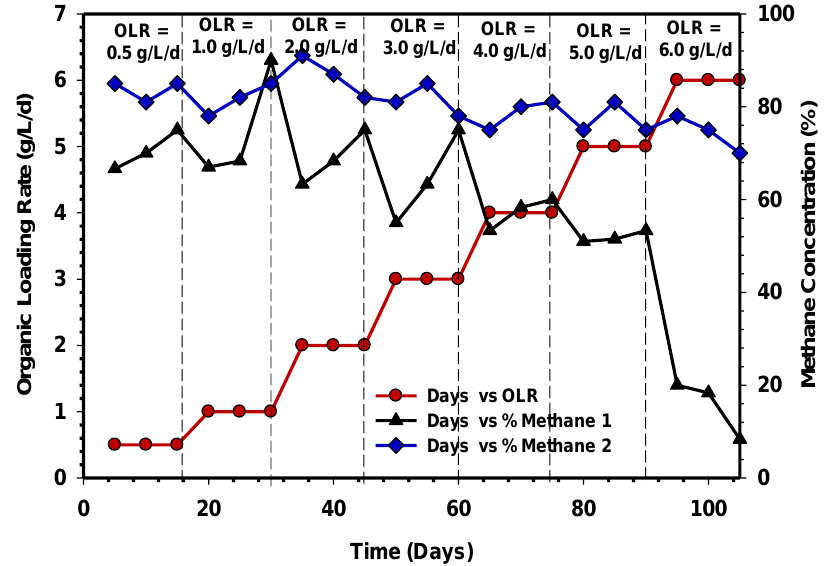
Figure 7. Methane concentration over time in UASB 1 and 2. Furthermore, the reduction in methane concentration in UASB 1 indicates a sign of inhibition of the methanogens due to VFA accumulation, as well as a low pH. However, the UASB 2 system maintained a high concentration of methane above 70% throughout the different stages of OLR (Figure 7), and this depicts a stable state of the system with no sign of inhibition. Therefore, comparatively, the performance of UASB 1 containing non- acclimatised seed sludge revealed unstable methane gas production. The two experi- mental results revealed that UASB 2 is more efficient in biogas, methane, and SMP, com- pared with a UASB 1 reactor of the same configuration and different seed sludge. A sim- ilar result was reported by Torkian et al. [15] with a UASB reactor. Still, the results ob- tained from the previous study were lower (0.2 to 0.28 LCH 4 /gCOD removed ) than UASB 2 in this study. 3.4. TAN Concentrations of the Reactors The TAN concentration profile of UASB 1 and UASB 2 over a period of time at vari- ous OLRs are presented in Figure 8. Research has shown that during protein hydrolysis in AD, a high concentration of TAN is usually produced [38]. It can be inferred that the concentration of TANs for UASB 2 from OLR 0.5 to 3 gCOD/L/d were 86, 163, 214, and 305 mg/L, respectively. Meanwhile, the concentration of TANs in UASB 1 were found as 42, 92, 128 and 136 mg/L for OLR 0.5 gCOD/L/d to 3 gCOD/L/d, respectively.